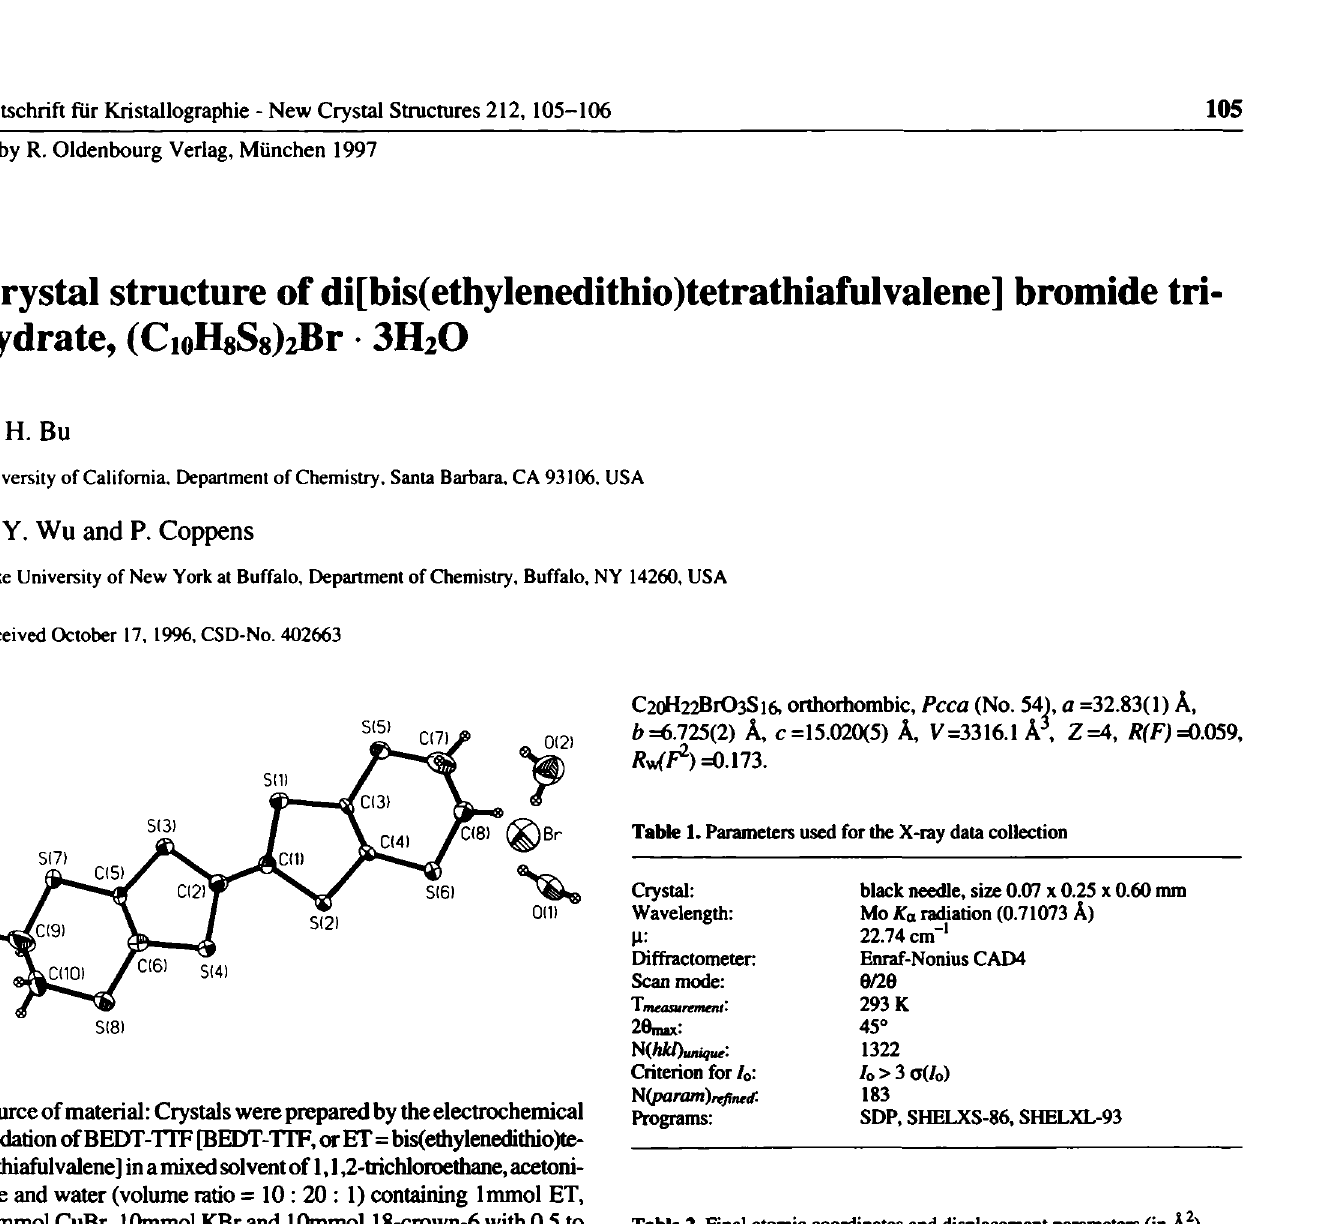
Table 2. Final atomic coordinates and displacement parameters (in Â 2